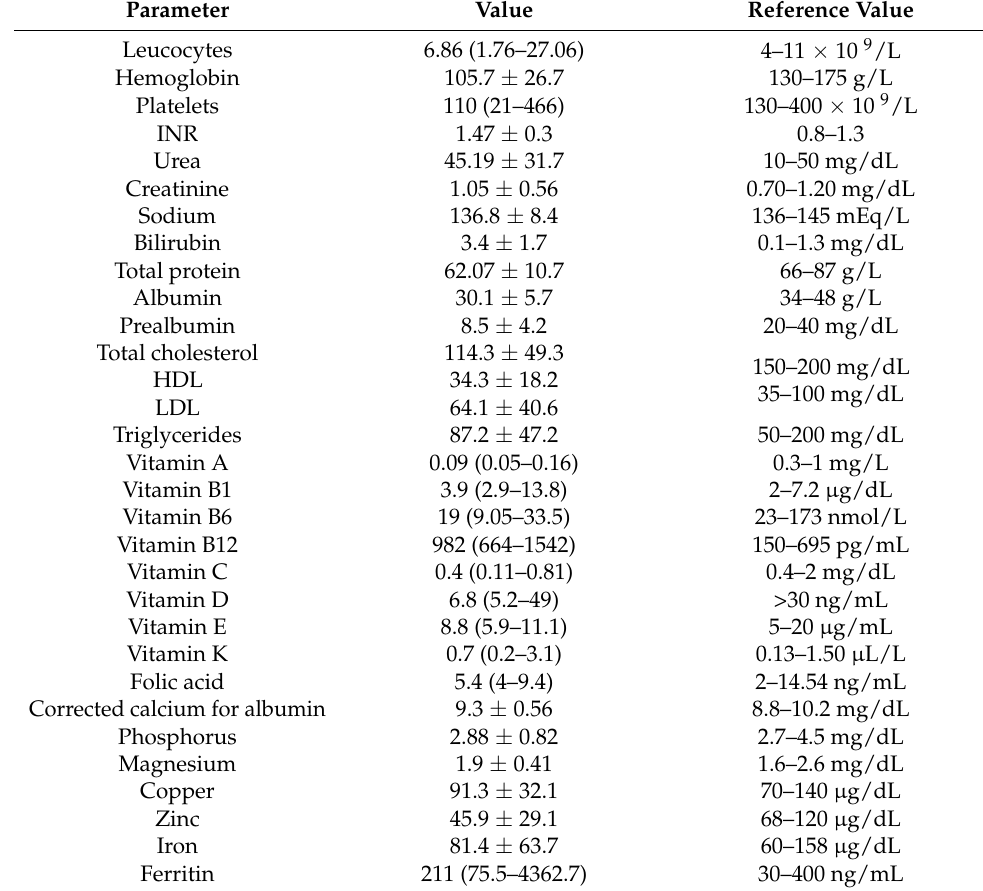
Table 2. Baseline levels for all